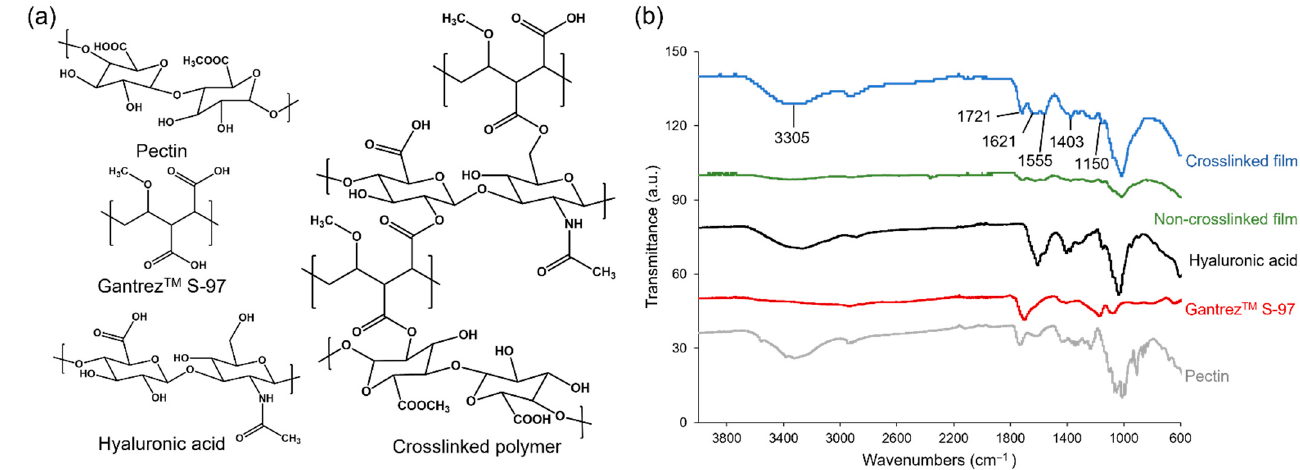
Figure 2. ( a ) The structures and ( b ) IR spectra of hydrogel ingredients, non-crosslinked, and crosslinked hydrogel films.